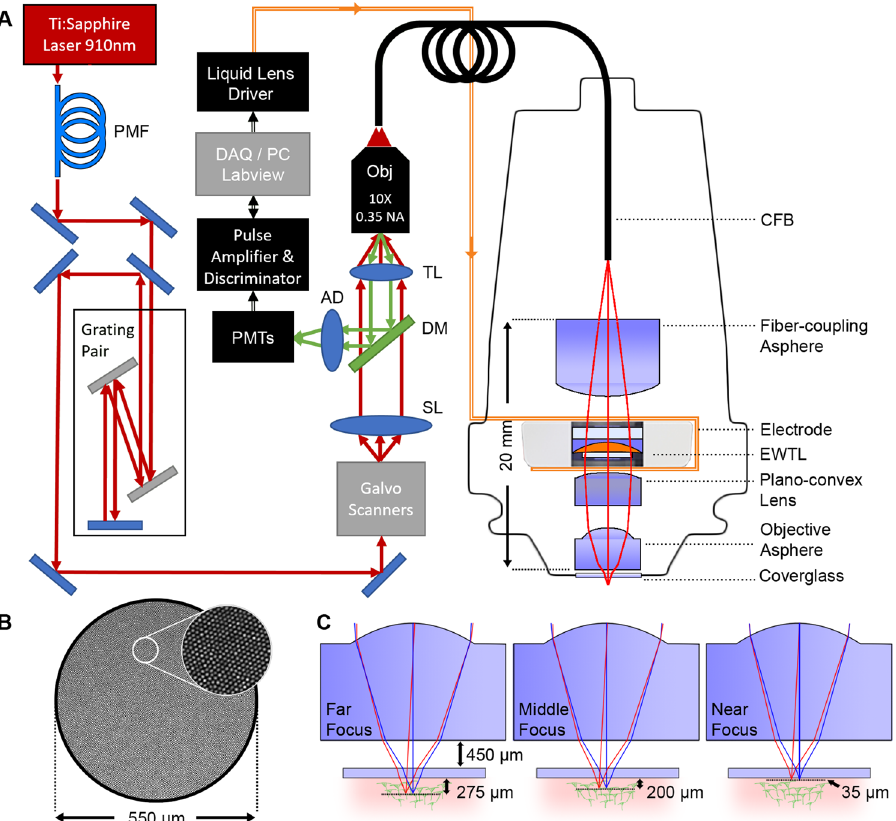
Figure 1. 2P-FCM imaging system. ( A ) Pulses from a Ti:Sapphire laser at 910 nm are spectrally broadened through a polarization maintaining fiber (PMF) and pre-chirped using a grating pair pulse stretcher. The excitation laser is scanned across the surface the coherent fiber bundle (CFB) through a galvanometric scanning mirror pair, scan lens (SL) and tube lens (TL) relay, and focused with a 10X 0.35 NA Olympus objective. Distal to the CFB, the 2P-FCM optics focus the excitation light from the CFB cores onto the sample through an electrowetting tunable lens (EWTL). Fluorescence emission is collected by the 2P-FCM optics, relayed through the CFB and directed to a photon-counting photo-multiplier tube (PMT) after passing through a dichroic mirror (DM), achromatic doublet (AD), and filter. The PMT signal is amplified and transformed to logic levels to be detected by the data acquisition system on the computer (DAQ/PC). The computer also controls the voltage applied to the EWTL through a driver and flexible electrode. ( B ) Detail of the fiber-core pattern of the CFB. ( C ) Zemax simulation of 2P-FCM axial-scanning using specified EWTL lens parameters from manufacturer. The working distance to a #1 coverslip (thickness ~140 µ m) is 450 µ m. EWTL Voltage (V RMS )